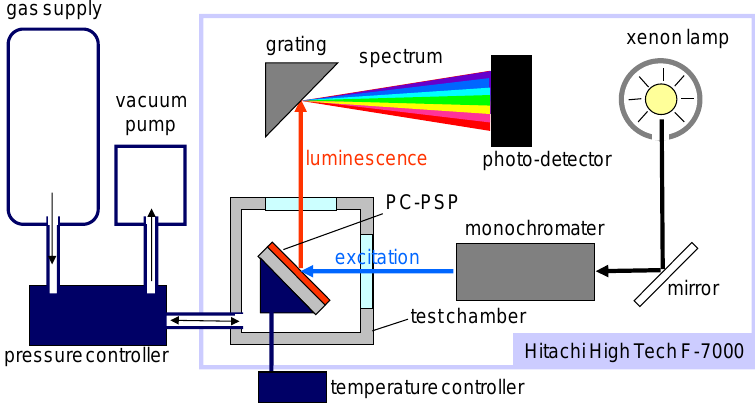
Figure 2. Schematic of the PC-PSP calibration